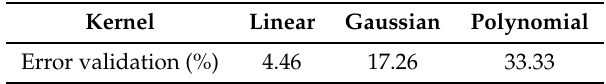
Table 2. Results of the leave-one-out cross validation for support vector machine (SVM) with different